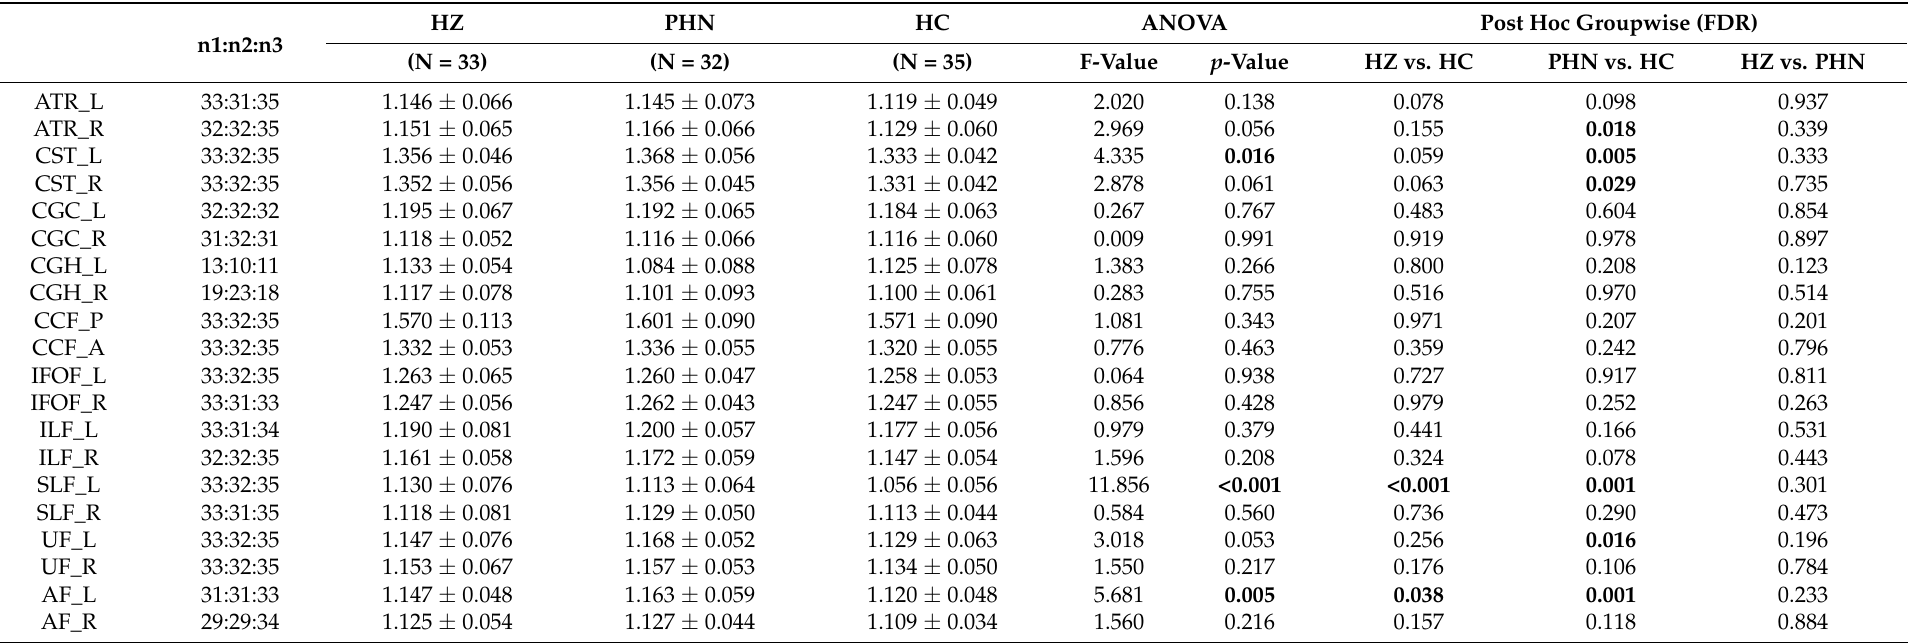
Table 5. Comparison of the mean AD among the three